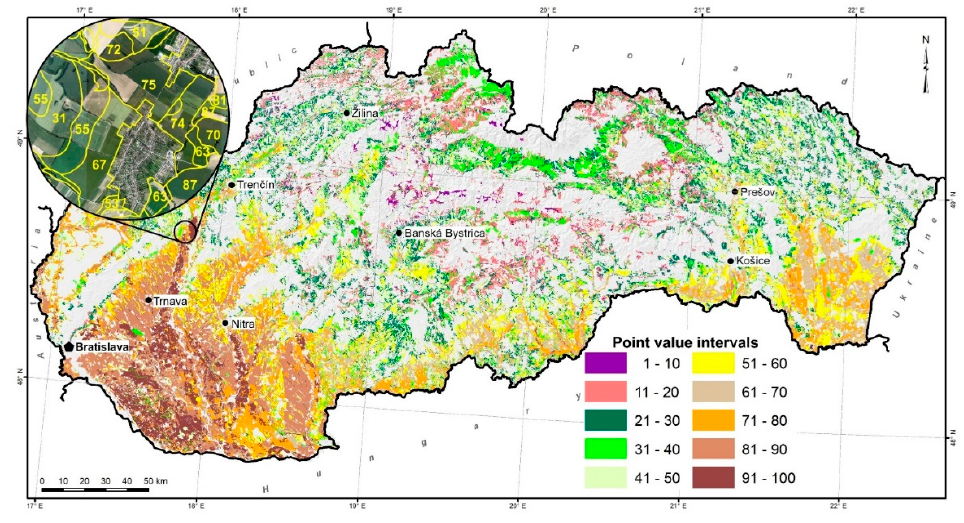
Figure 2. Spatial identification of point values of agricultural soils in Slovakia [9].